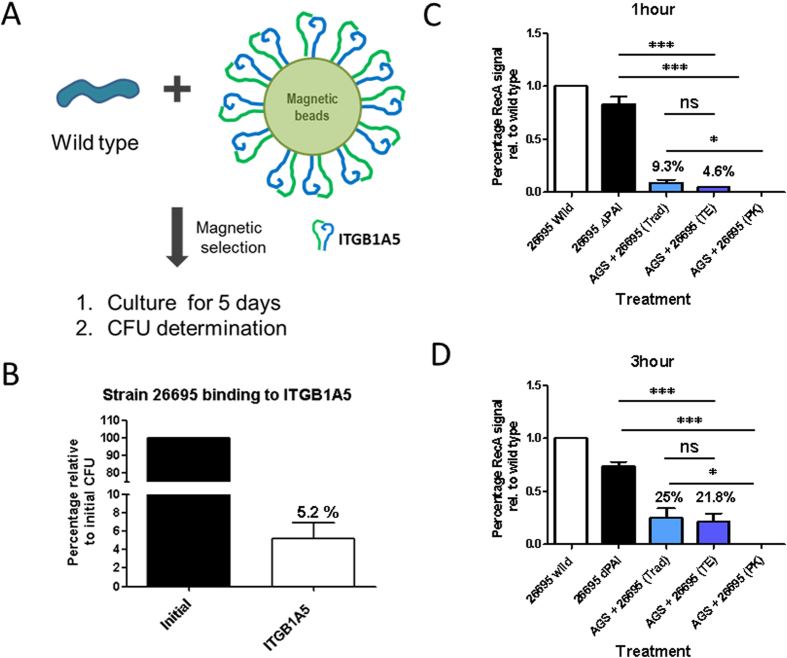
Availability of Cag apparatus and binding capacity of H. pylori in infection assays.(A) Scheme for the binding test of strain 26695 to ITGB1A5 coated beads (See Material and Methods). (B) Percentage of colony forming units recovered after binding assay to ITGB1A5 coated magnetic beads, relative to the total amount of bacteria present in the initial suspension. n = 4. T-test was used for the statistical analysis. (C,D) Quantification of RecA signals by densitometry analysis and after normalization to stain free signals, the percentage were calculated relative to the signals given by the lysates of the original amount of bacteria. Statistical analysis applied was one way ANOVA, with post-Turkey test for comparison between each different treatment. n = 3. *P < 0.05; **P < 0.01; ***P < 0.001, ns (not significant) P > 0.05.